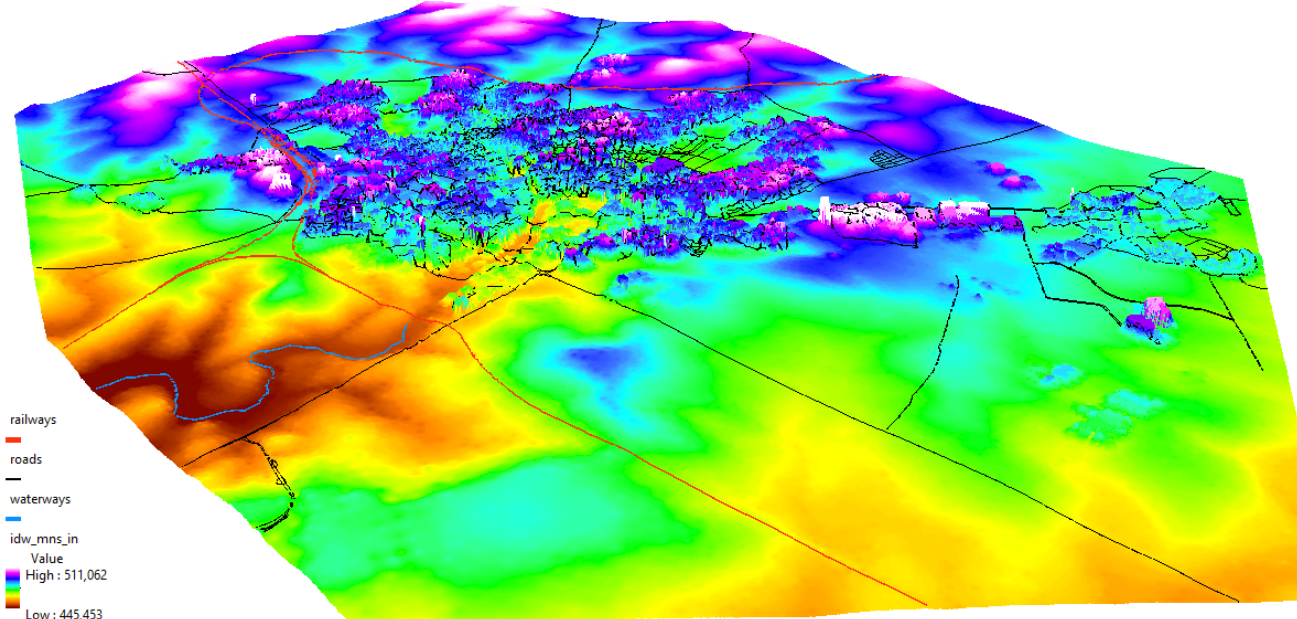
Figure 4. Generated DSM of the